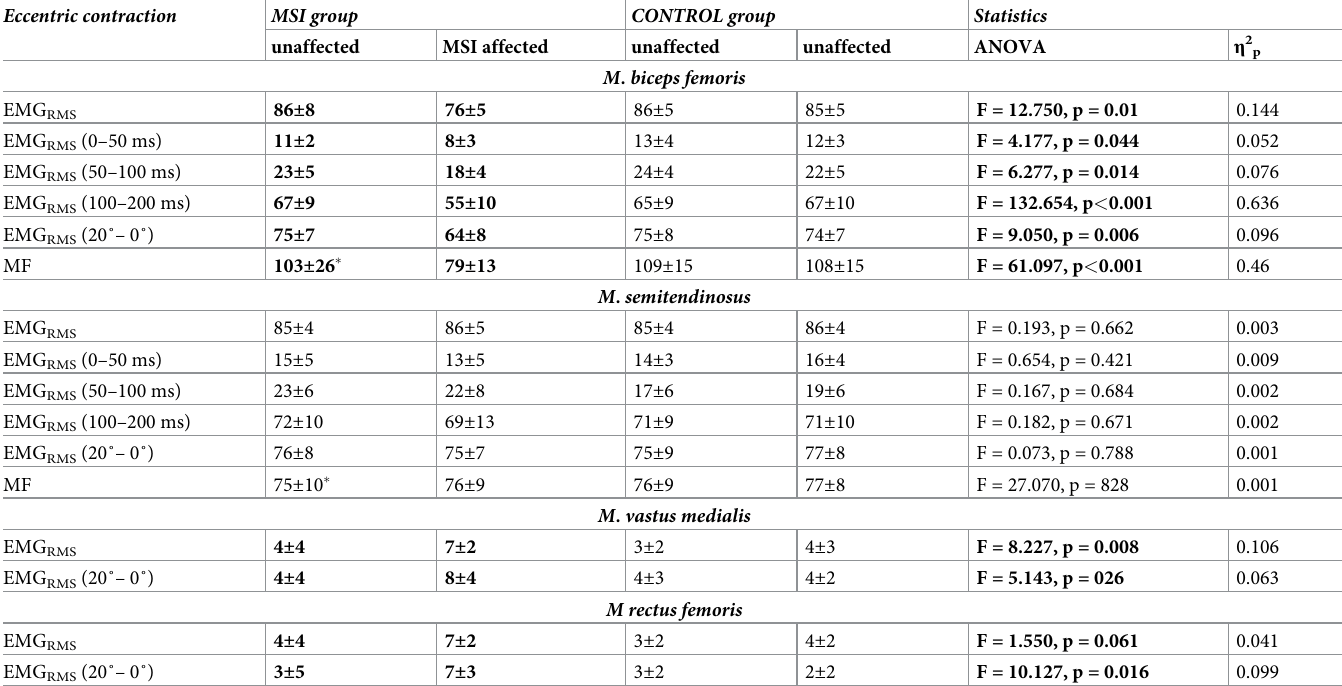
Table 3. Neuromuscular